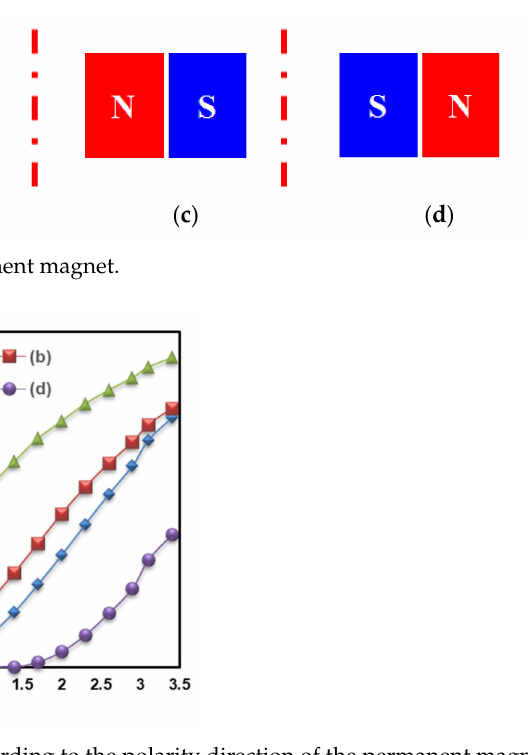
Figure 9. Total electromagnetic force according to the polarity direction of the permanent magnet.